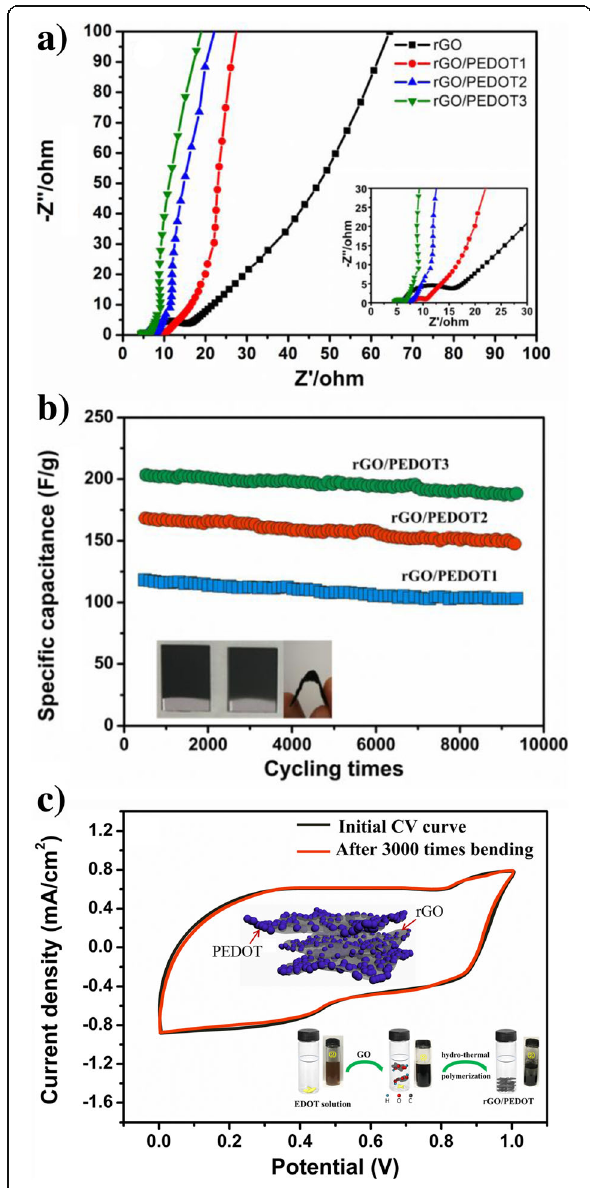
Fig. 9 a EIS performance of hydrothermal-treated GO and hydrothermal-polymerized rGO/PEDOT. b Cycling performance of rGO/PEDOT electrodes at a 1.0 A/g scan current density, the insets are optical picture of rGO/PEDOT deposited on ITO and cotton fabric. c Capacitance reliability of rGO/PEDOT3 flexible